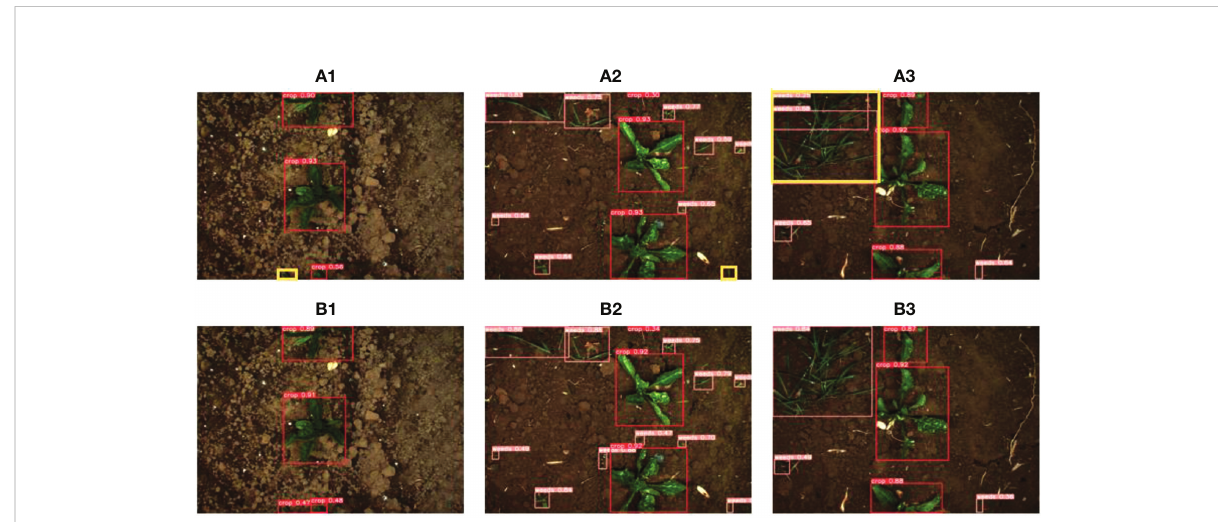
FIGURE 8 Visualization of YOLO5 (Figures a) and TIA-YOLOv5 (Figures b) for detecting sugarbeet and weed.